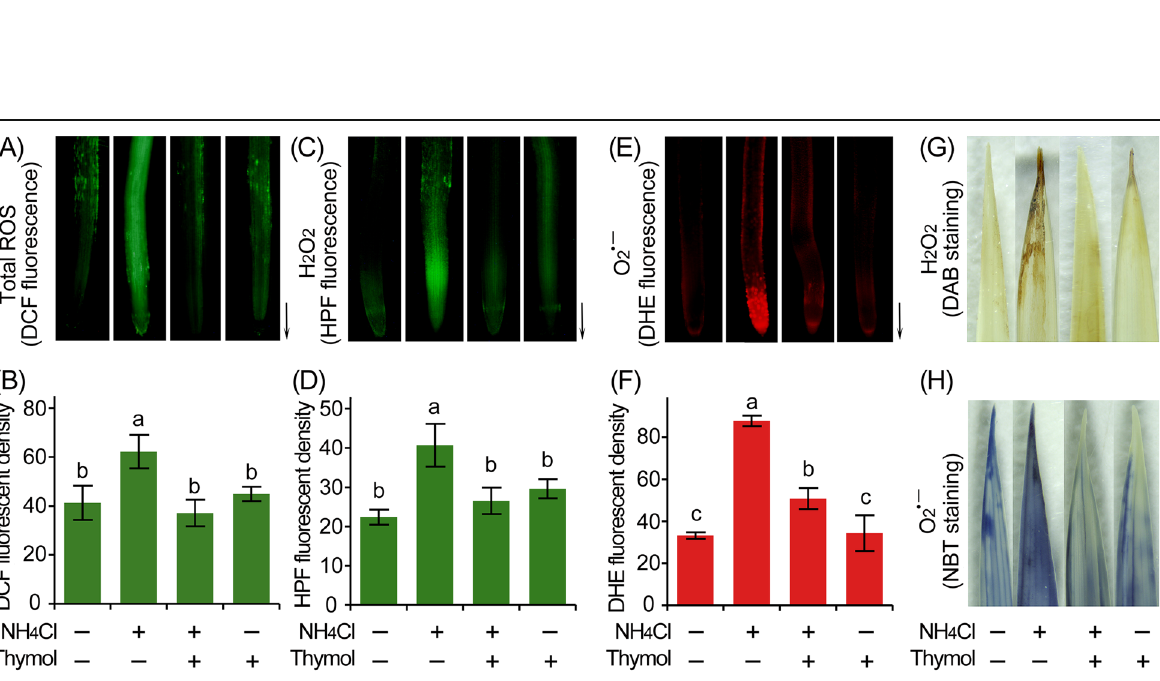
Fig. 3 Thymol repressed ammonium-induced ROS accumulation in rice seedlings. (A-B) Total ROS level in root. (C-D) H 2 O 2 level in root. (E-F) O 2 • - level in root. (G) H 2 O 2 level in leaves. (H) O 2 • - level in leaves. The black arrows in A, C, and E indicates the direction of root tip. Different lowercase letters in B, D, and F indicate that the mean values of three replicates are significantly different among treatments ( P < 0.05, ANOVA,